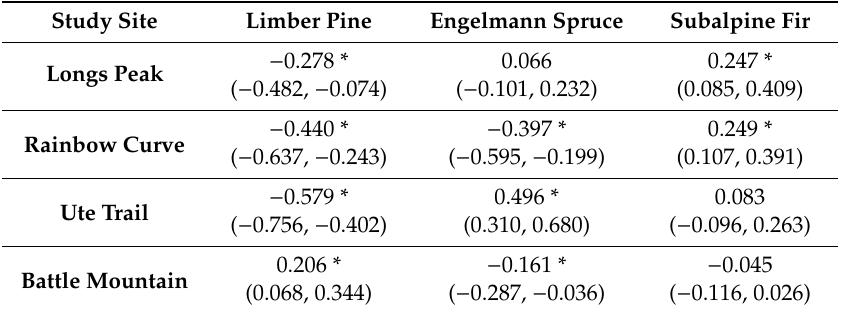
Table 5. Estimated di ff erences between windward proportions and solitary proportions. Study